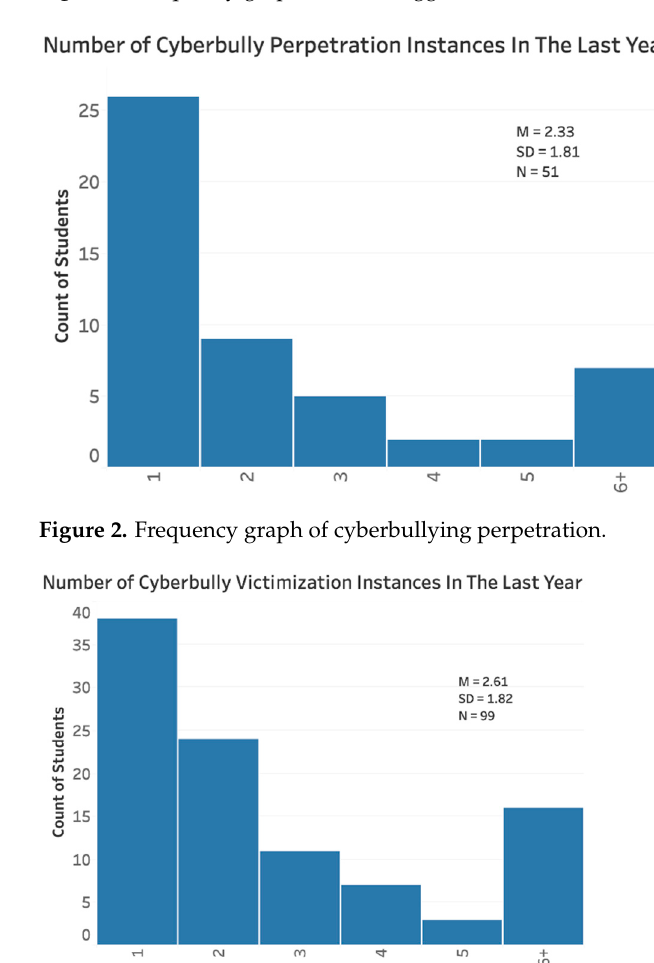
Figure 1. Frequency graph of verbal aggression.